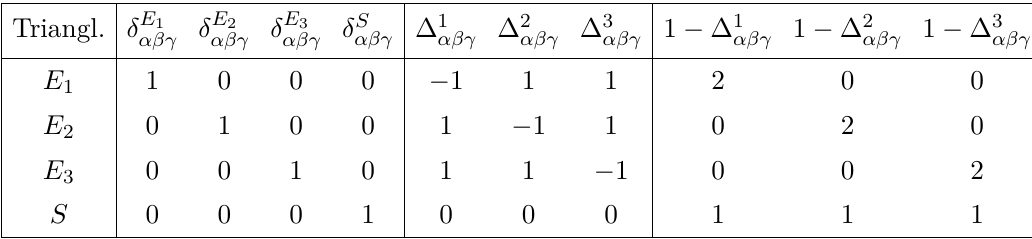
and their variations ∆ i , defined in (2.5) and (2.7), αβγ αβγ